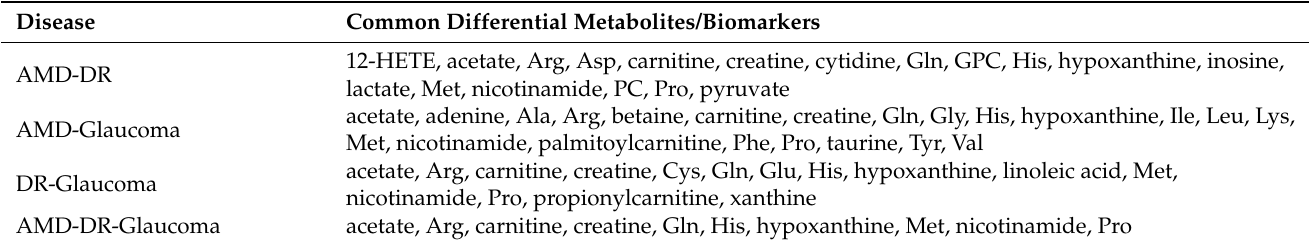
Table 5. Shared differential metabolites/biomarkers between different retinal diseases.